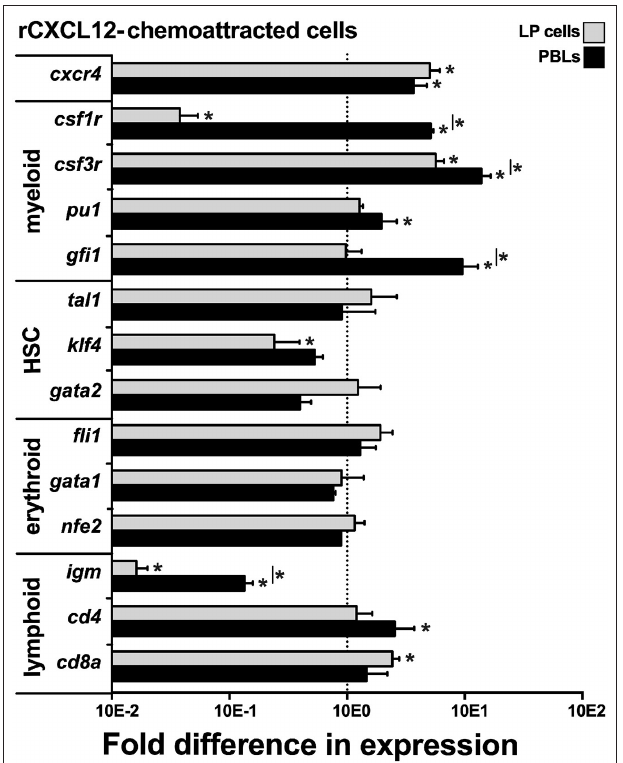
FIGURE 6 | X. laevis rCXCL12 chemoattracts myeloid-lineage cells. Chemotaxis assay using the optimal concentration of rCXCL12 (10 − 3 ng/ml) was performed on liver periphery (LP) cells and peripheral blood leucocytes (PBLs; 10 4 LP cells or PBLs/well, cell from five individual frogs, N = 5), and the chemoattracted cells were examined for their gene expression of crcr4 (receptor for CXCL12); lineage specific markers for myeloid: csf1r (macrophage), csf3r (granulocyte), pu1 , gfi1 ; HSC-associated: tal1 , klf4 , gata2 ; erythroid: fli1 , gata1 , nfe2 , and lymphoid cell populations: igm (B cell) ; cd4 (T helper cell); and cd8 (cytotoxic T cell) by qPCR. All gene expressions was quantified relative to the gapdh endogenous control and normalized against the corresponding gene expression observed in the LP cells or PBLs (input, indicated by the dashed line ) used in these chemotaxis experiments. Results are means ± SEM, (*) denotes statistical differences from the gene expression in total input LP or PBL population (indicated by the dashed line ) and (*) above horizontal bars denote statistical differences between LP cells and PBLs, P < 0.05.